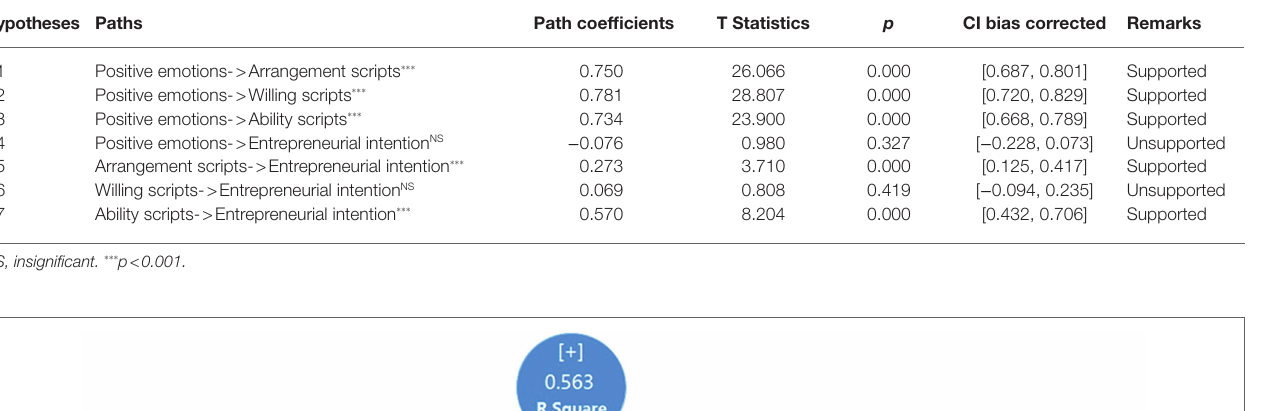
TABLE 8 | Outcome of structural model examination.